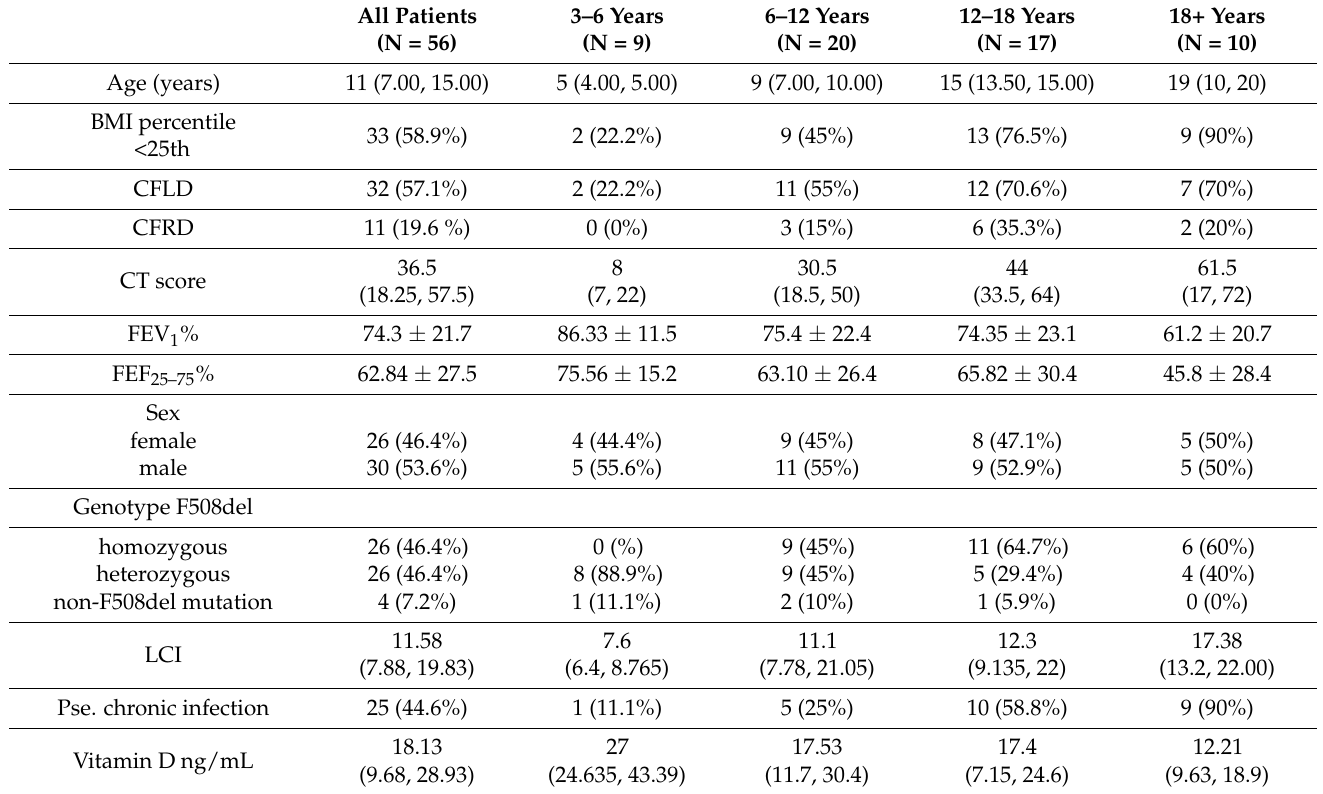
Table 1. Patients’ characteristics by age category.